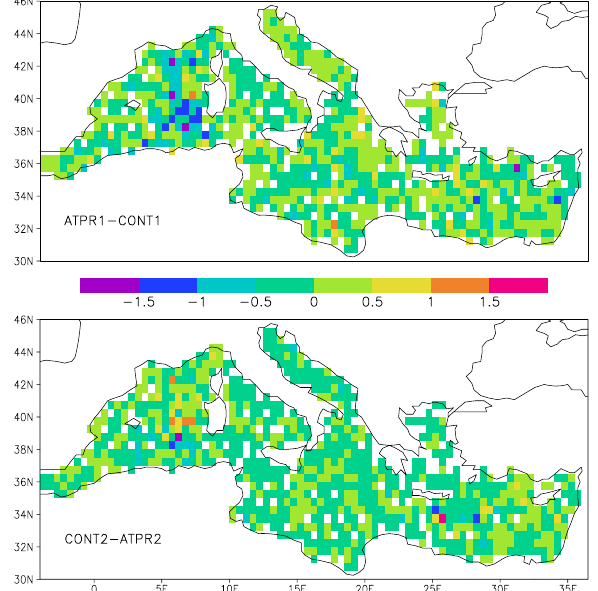
Fig. 5. Spatial distribution of differences between RMS of SLA residuals (cm) in experiments ATPR1 and CONT1 (top panel), and between CONT2 and ATPR2 (bottom panel). The RMS of residu- als is averaged over squares with 1/2 ◦ resolution. The differences are displayed only in squares that had more than 100 observations during the year 2009.